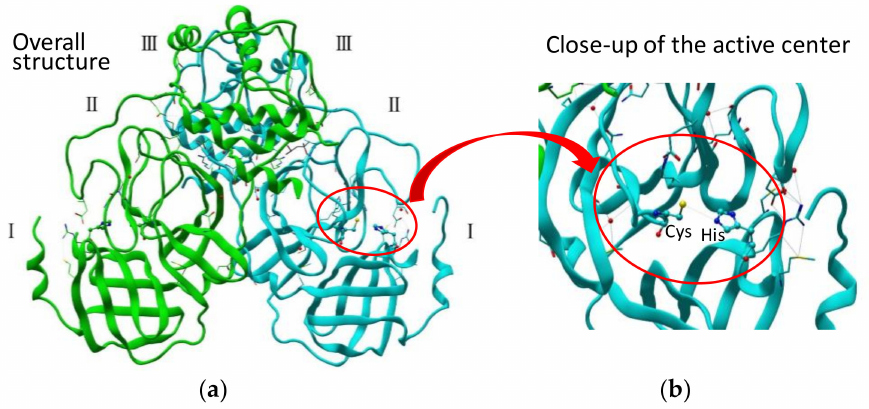
Figure 1. ( a ) Crystal structure of SARS-CoV 3CL pro active dimer (PDB code 1Q2W). ( b ) Structure of the active center.